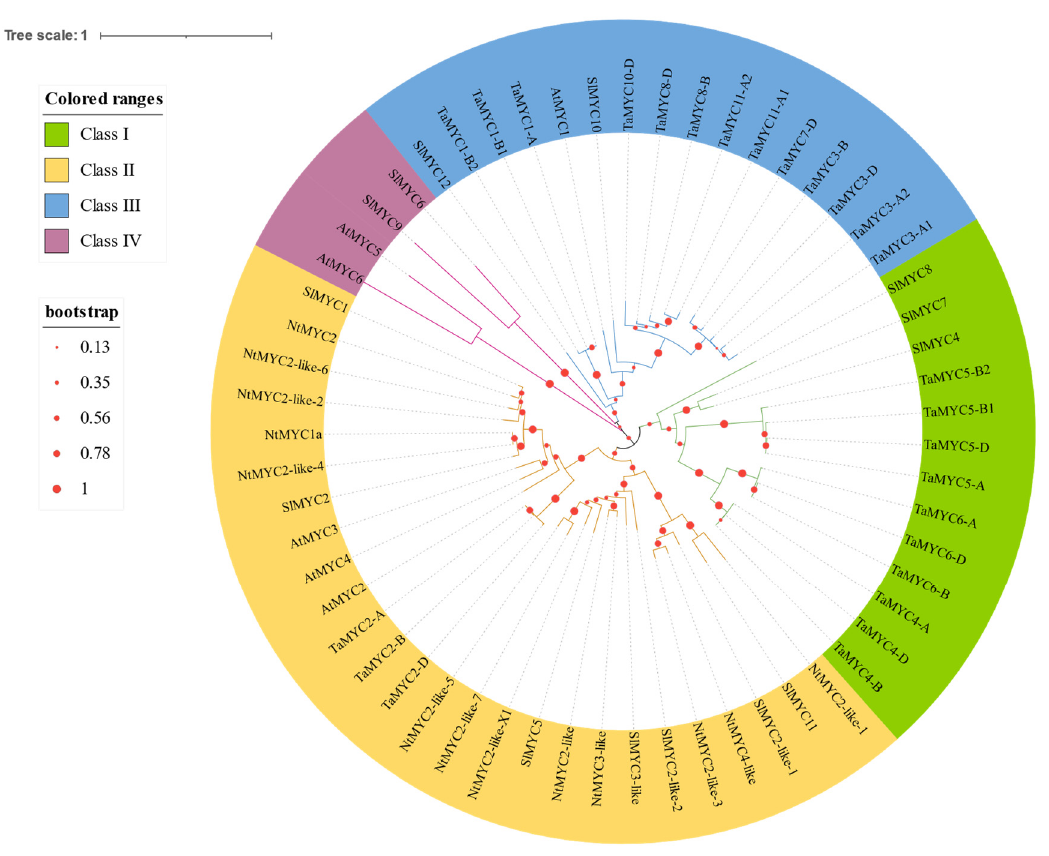
Figure 2. Phylogenetic tree of MYC proteins. The phylogenetic tree was carried out based on protein alignments. SlMYC of Solanum lycopersicum , TaMYC of Triticum aestivum , NtMYC of Nicotiana tabacum , and AtMYC of Arabidopsis were used. The neighbor-joining method is used with 1000 bootstrap trials.